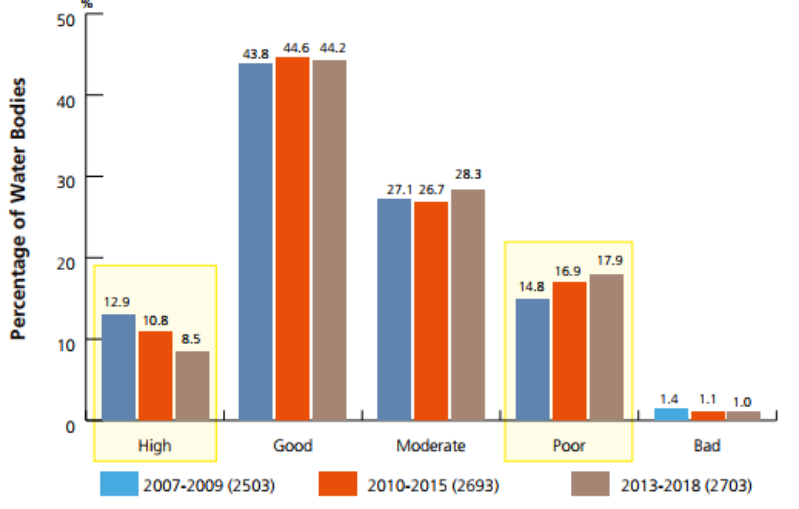
Figure 1. Percentage changes in water quality levels over a three-assessment period from 2007 to 2018 [24].